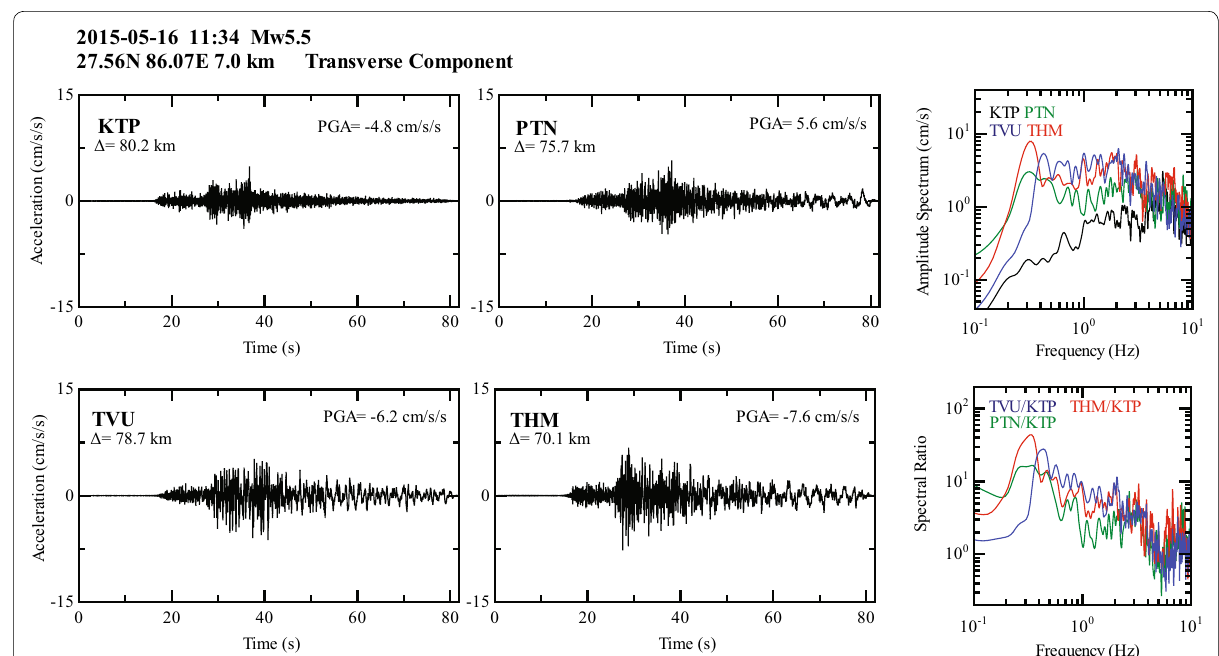
Fig. 5 Acceleration waveforms, Fourier spectra, and spectral ratios of the Mw5.5 aftershock for the transverse component. This aftershock occurred on the same day as the largest aftershock (Mw7.3) about 75 km east of Kathmandu